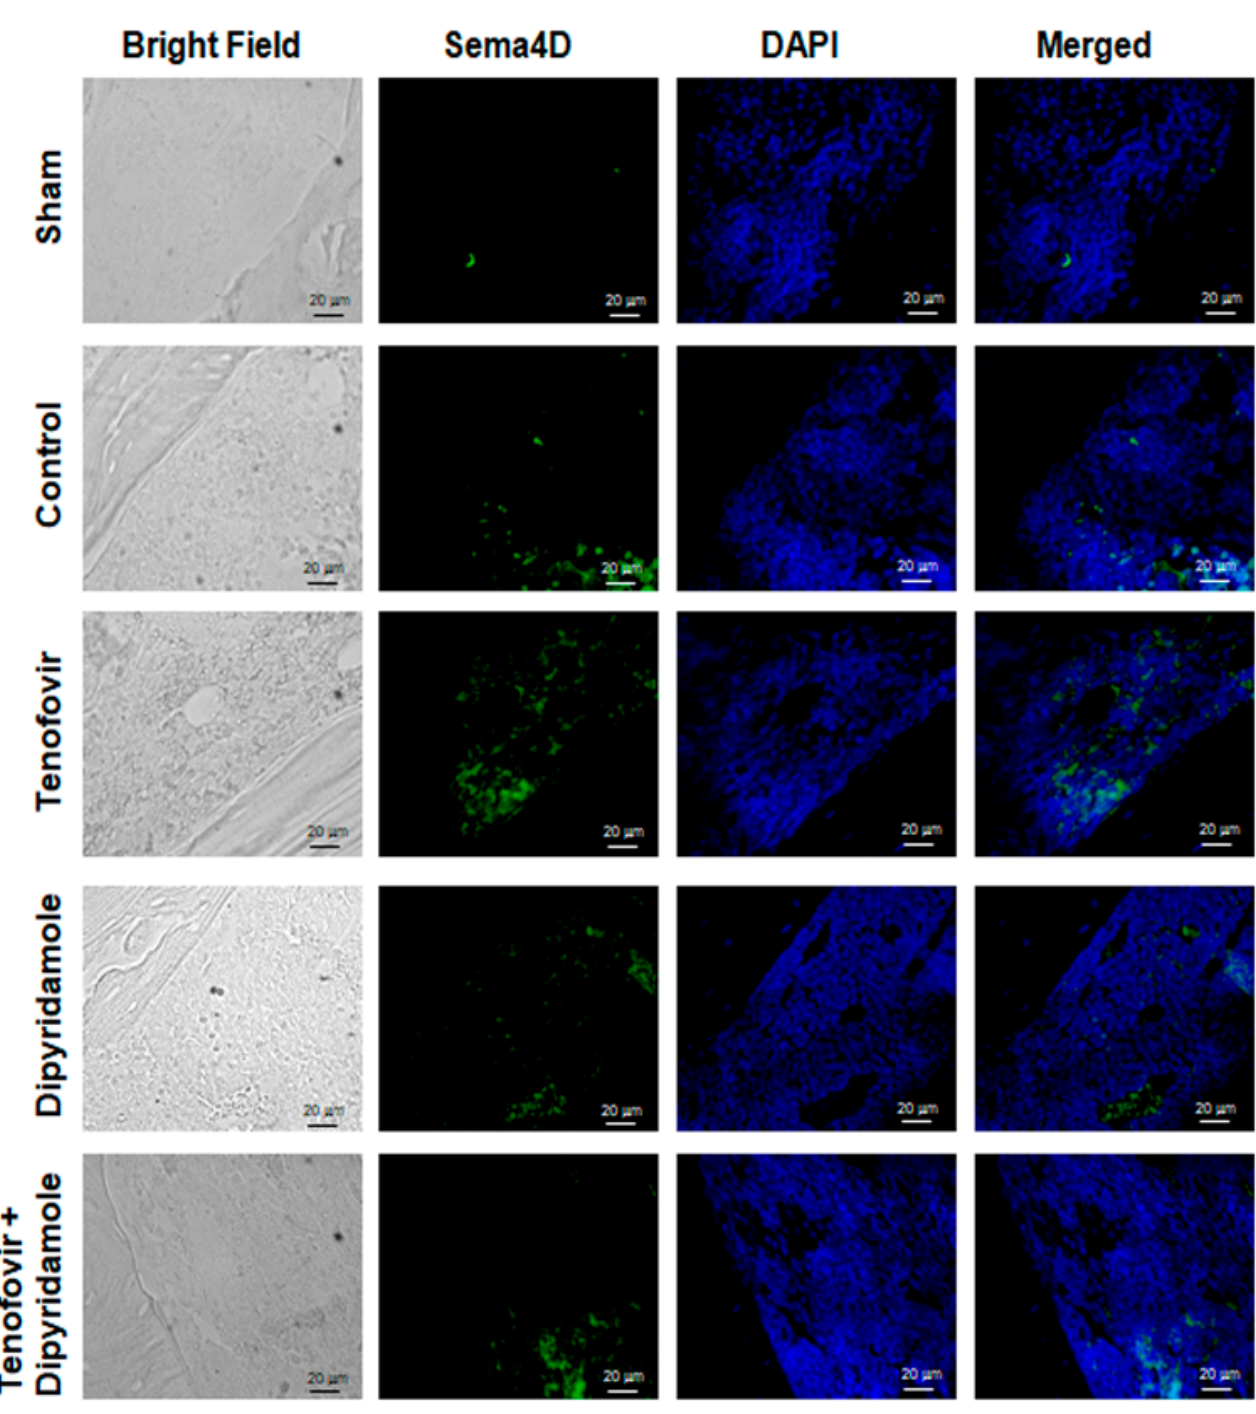
Figure 1. OVX mice treated with tenofovir showed an increased expression of Sema4D. Long bones were processed, and immunohistologic staining was carried out. Representative images are stained for Sema4D (green); Nuclei are shown in blue (DAPI). All images were taken at 40 × magnification and scale bar indicates 20 µ m segment.